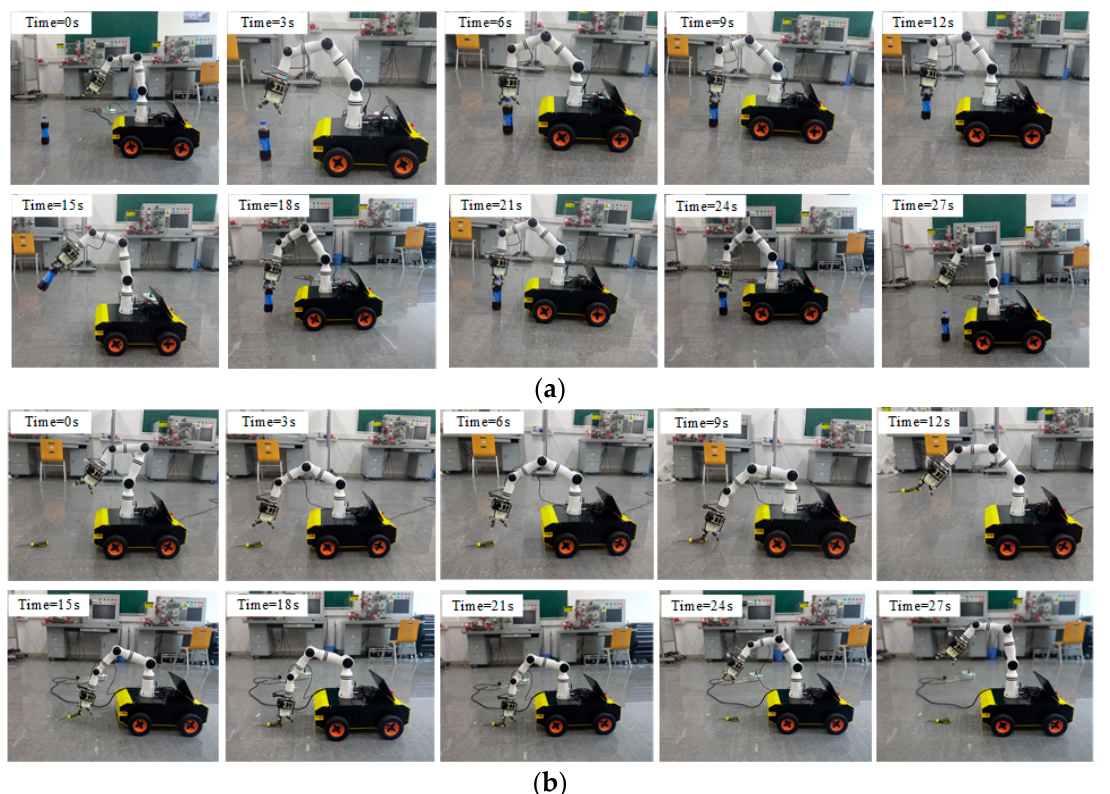
Figure 15. Robot grasping experiments. ( a ) Three fingers grasping object. ( b ) Two fingers grasping object.